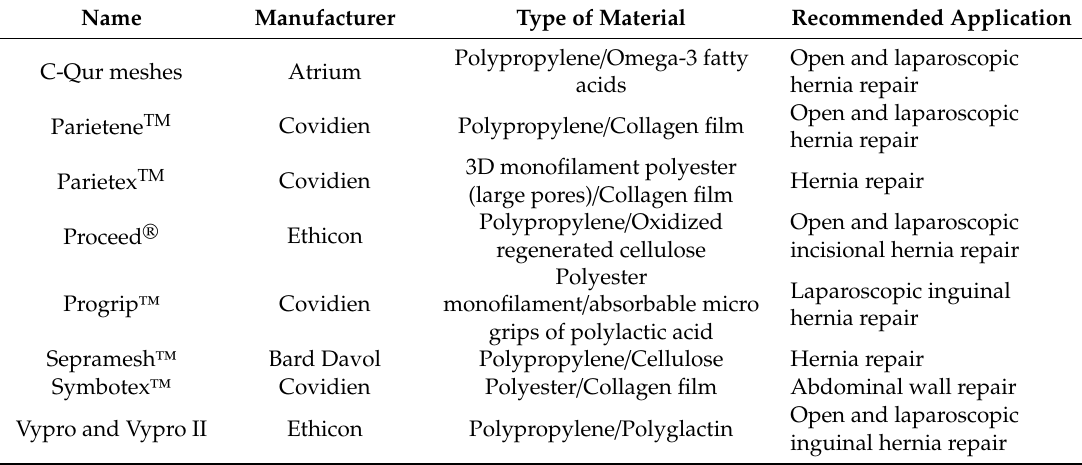
Table 2. Commercially available composite meshes for hernia